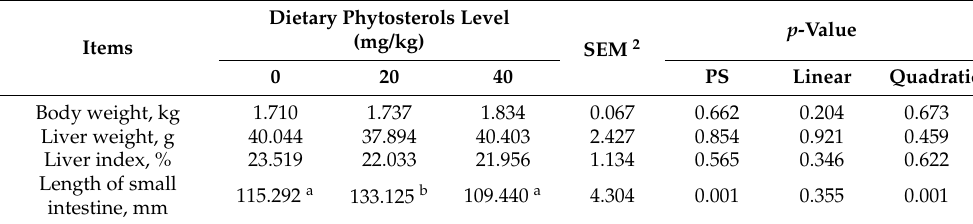
Figure 1. Effects of dietary phytosterols on tibia quality in aged laying hens. ( A ) Length of tibia, n = 12; ( B ) bone mineral density (BMD), n = 8; ( C ) bone mineral content (BMC), n = 8. Data are presented as mean ± SEM. Table 4. Effects of dietary phytosterols on the length of small intestine and the weight of liver in aged laying hens 1